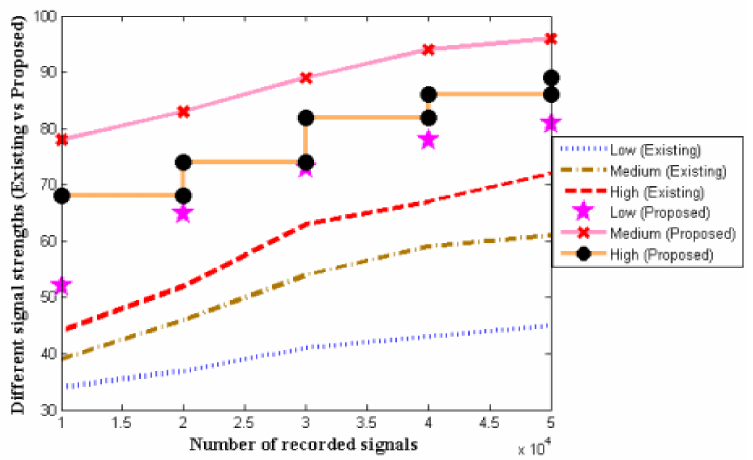
Figure 3. Measurement and comparison of signal